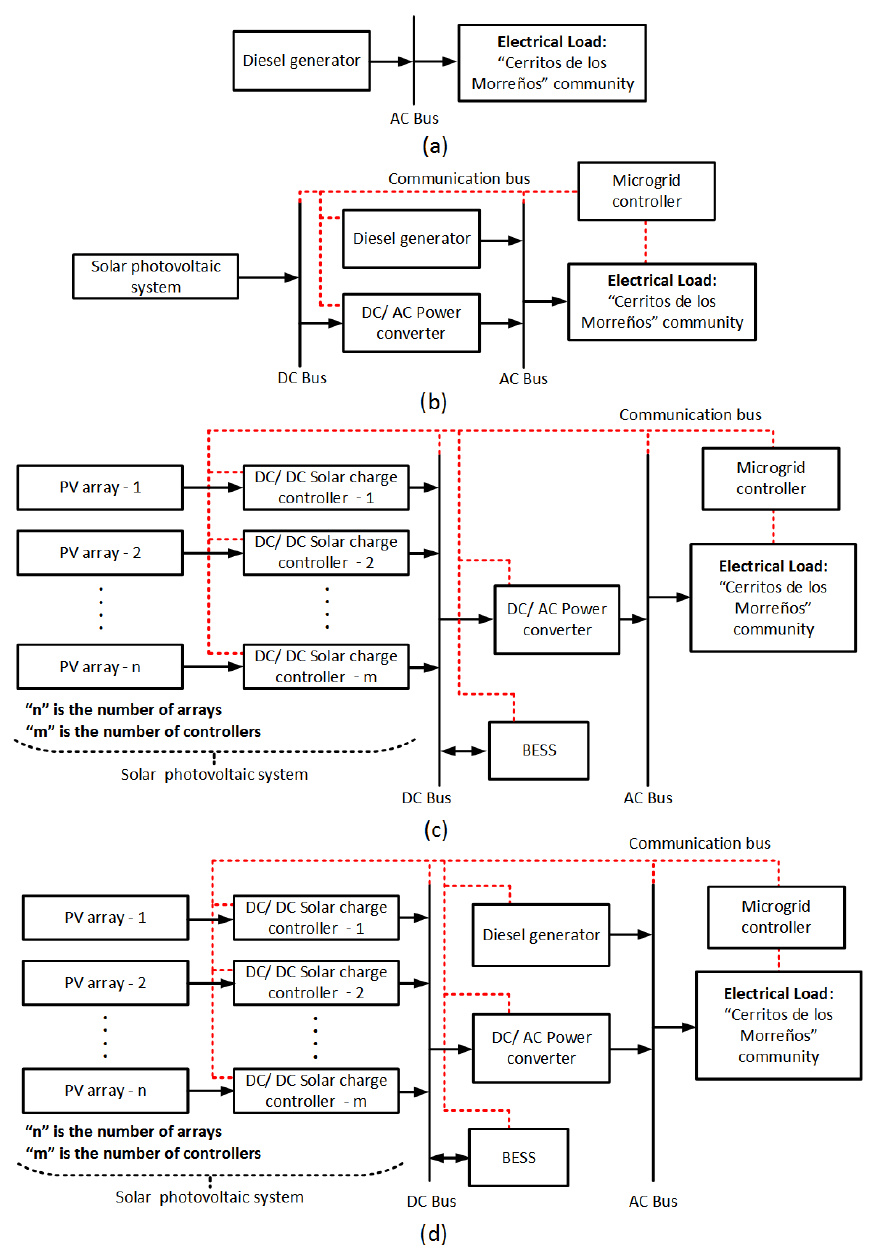
Figure 2. Proposed configurations for supplying electricity to Cerrito de los Morreños, ( a ) stand- alone diesel generator, ( b ) SPVS/diesel generator (no BESS), ( c ) SPVS/BESS, and ( d ) SPVS/diesel generator/BESS. The red dashed line connecting to the microgrid controller is the communication bus for data acquisition and control signals in configurations ( b – d